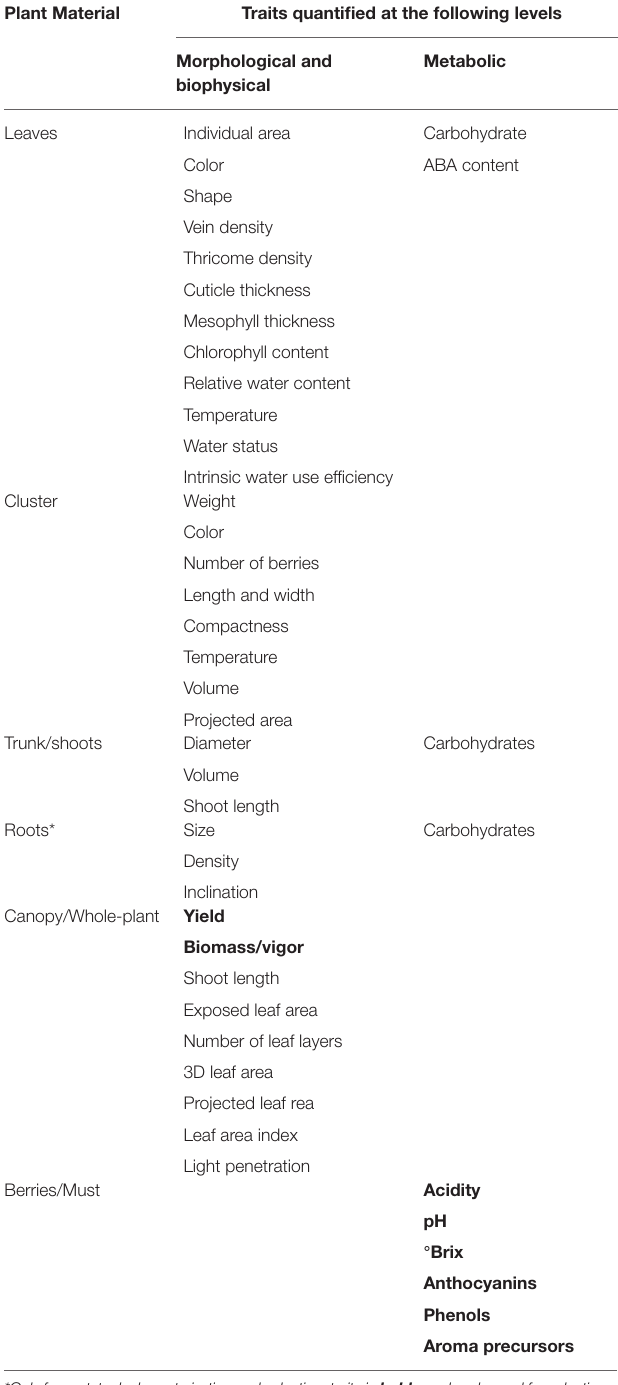
TABLE 2 | Non-exhaustive list of phenotypic traits used in studies focused on agronomic, morphological, and eco-physiological characterization of grapevine